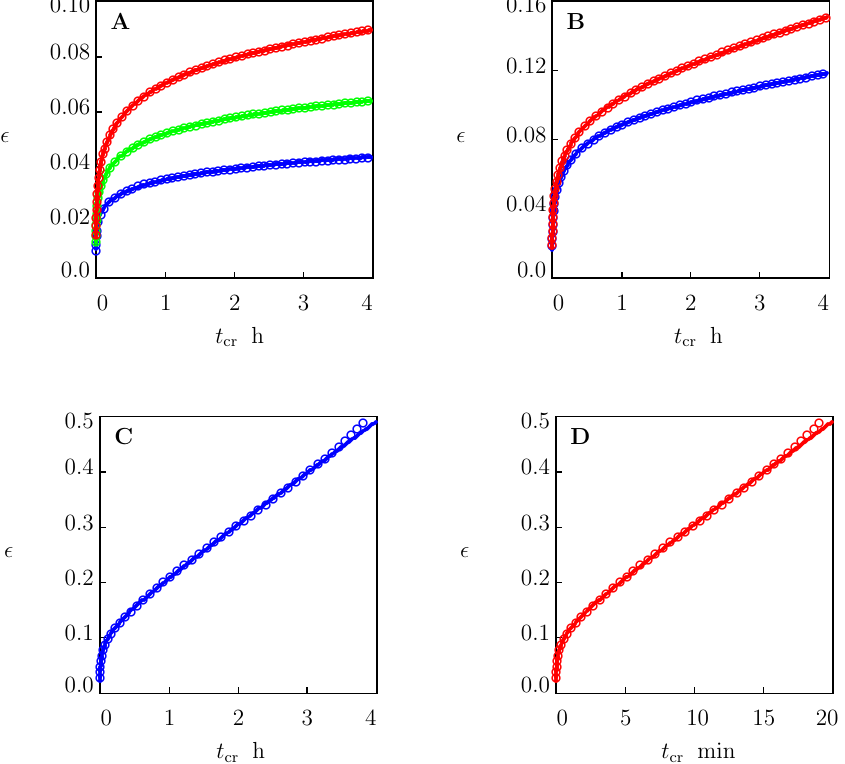
Figure 3. Tensile strain (cid:101) versus creep time t cr . Circles: experimental data in creep tests with various tensile stresses σ . Solid lines: results of numerical analysis. ( A )— σ = 9.0 (blue), σ = 11 (green), Figure 3: Tensile strain (cid:15) versus creep time t cr . Circles: experimental data in creep tests σ = 13 (red), ( B )— σ = 14.0 (blue), σ = 15 (red), ( C )— σ = 17.5 (blue), ( D )— σ = 20.5 (red) with various tensile stresses σ . Solid lines: results of numerical analysis. A – σ = 9 . 0 (blue), σ = 11 (green), σ = 13 (red), B – σ = 14 . 0 (blue), σ = 15 (red), C – σ = 17 . 5 (blue), D – σ = 20 . 5 (red) MPa.